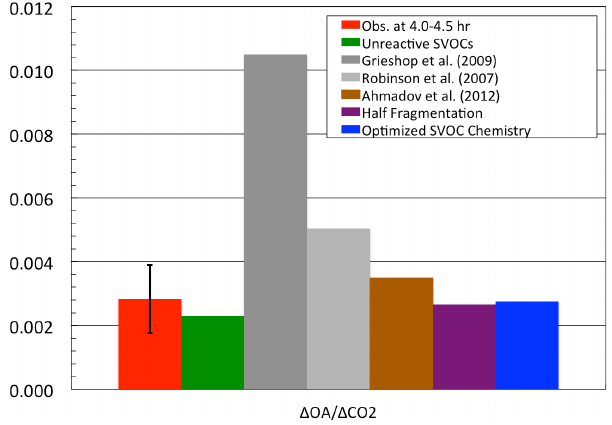
crease in (cid:49) OA / (cid:49) CO 2 with time. Changing the gas-phase